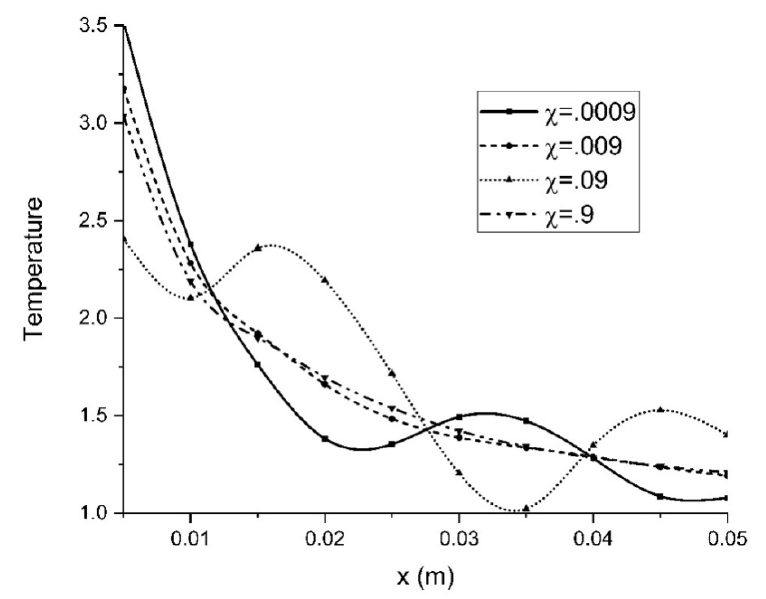
Figure 3. Temperature distributions w.r.t. skin depth for different values of time-delay Figure 4 demonstrates the thermal damage w.r.t. time t